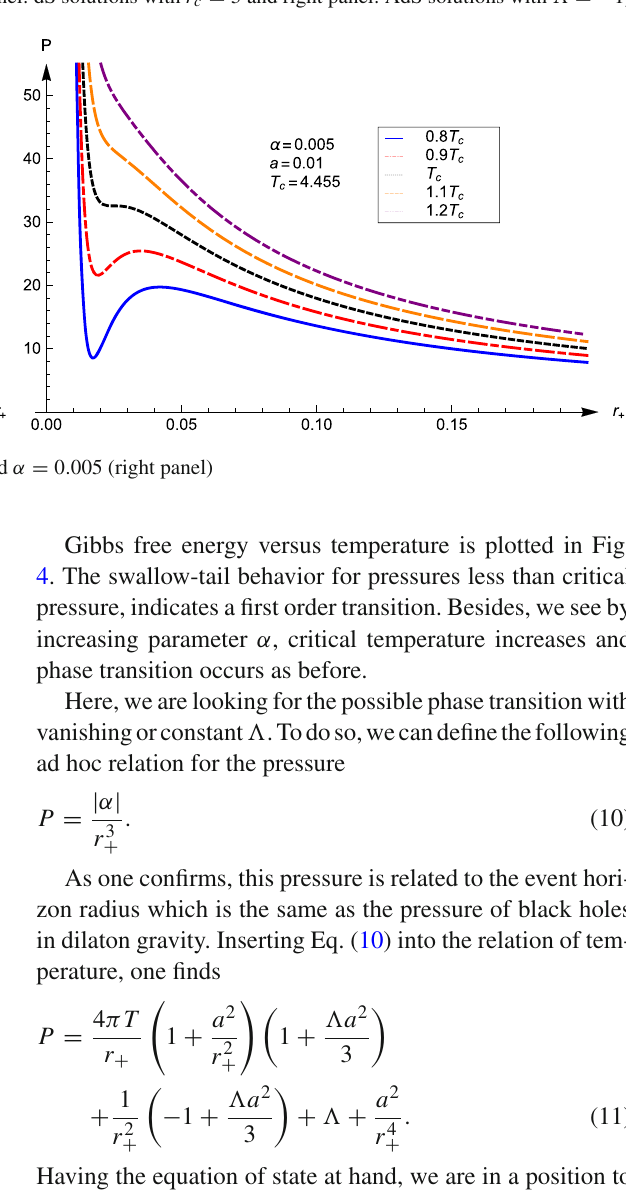
Fig. 1 (cid:3) r versus r with different α , where r + = 1, r − = 1 / 2: (left panel: dS solutions with r c = 5 and right panel: AdS solutions with (cid:2) = − 1)